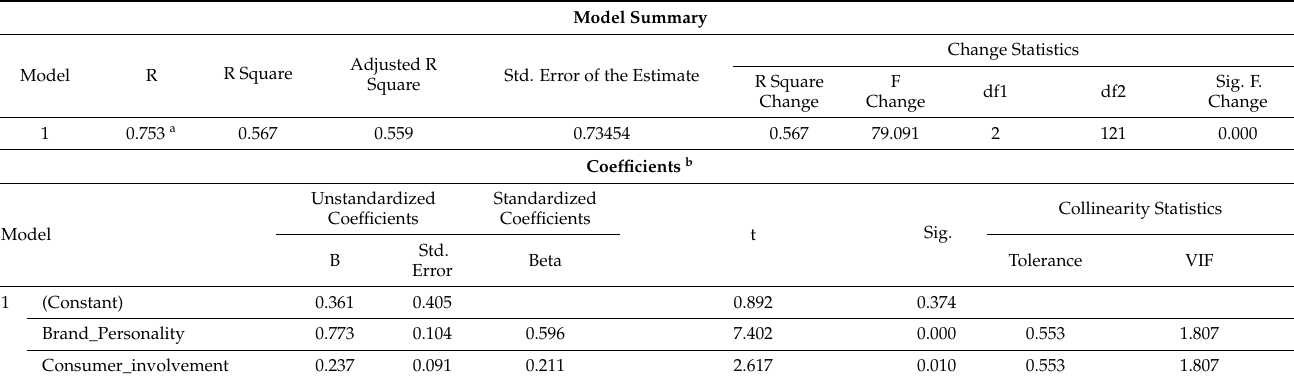
Table 5. Regression testing results. Relationship between the constructs. Model